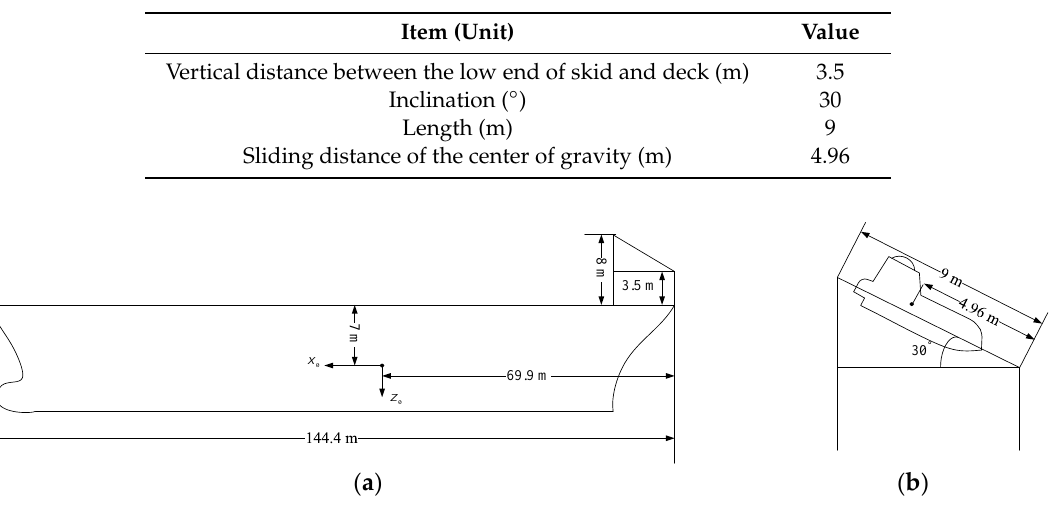
Table 3. Basic information of the skid.